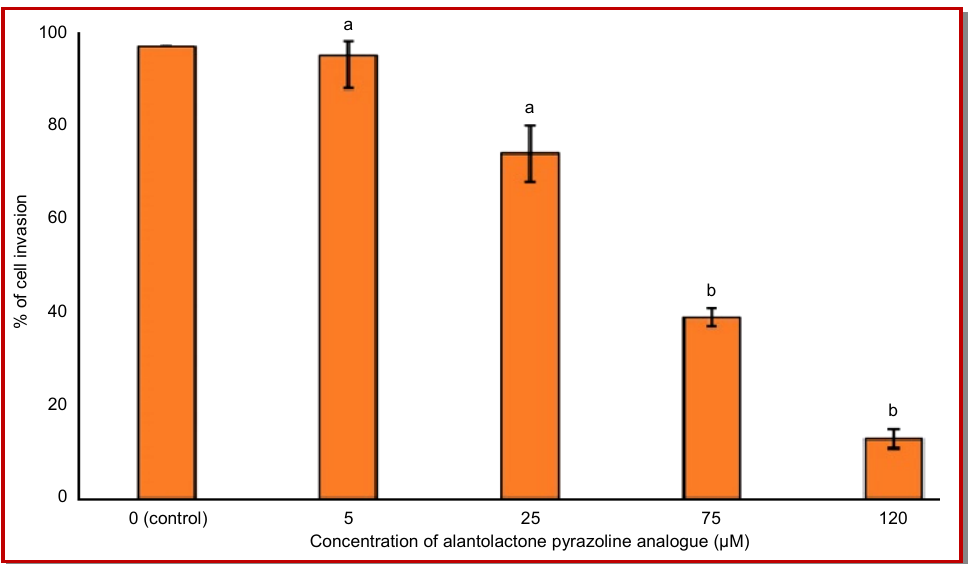
Figure 3: Graphical representation of the alantolactone pyrazoline analogue-induced reduction in the invasion of non-small cell lung cancer cells. Data are shown as the mean ± SD of three independent experiments by analysis of Student’s t -test. a p<0.05; b p<0.01 vs 0 µM We further evaluated the effect of APA on NCI-H460 cellular morphology and apoptosis using fluorescence microscopy and Hoechst 33258 staining. NCI-H460 cells were subjected to APA treatment using different con- centrations (0, 25, 75 and 120 μ M). APA induced signi- ficant nuclear morphological changes including chro- matin condensation and DNA fragmentation which can easily be seen in Figure 4. These nuclear morphological changes are hallmark of apoptosis. The bright blue